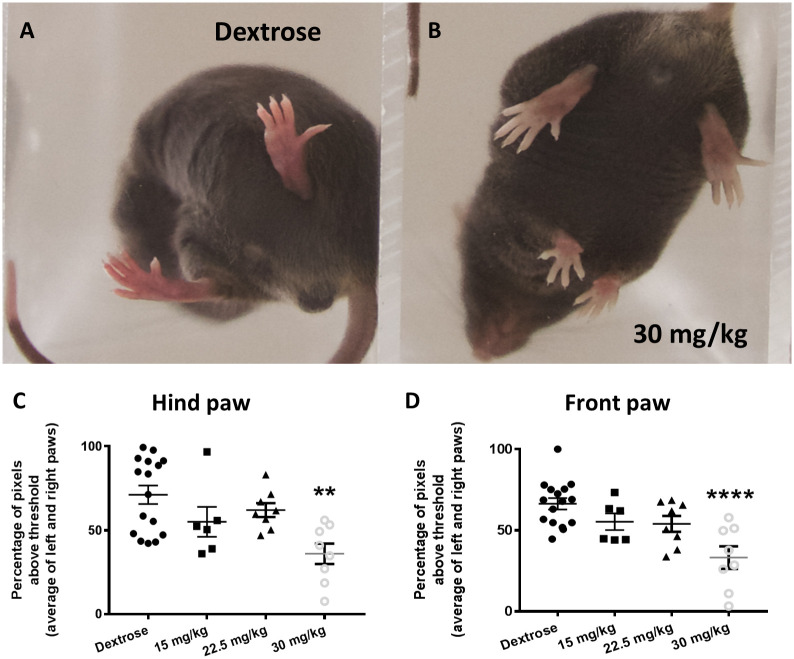
Hind and front paw coloration.Pixel threshold technique was used to quantify coloration of C57BL6/J mouse paws assessing images taken within 24 hours of ‘Day 30’ tissue collection time point. Example images of (A) control dextrose treated and (B) 30 mg/kg oxaliplatin treated mice used for threshold quantification of paw colour. Dot plots of (C) Hind and (D) Front paw quantification of pixel threshold for different treatment groups (a higher percentage equates to redder paws, whereas lower percentage equates to whiter paws) (Mean ± SEM; Dextrose n = 16, 15 mg/kg n = 6, 22.5 mg/kg n = 8, 30 mg/kg n = 8; p<0.01 = **, p<0.0001 = ****).